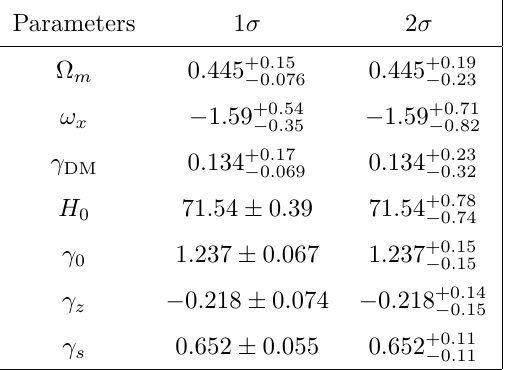
Table 1 . The best values ( Ω m , ω x , γ DM , H 0 , γ 0 , γ z , γ s ) and their 2 σ errors of the γ DM model parameters are obtained by using SGL+SNe+Hz observational data combination.